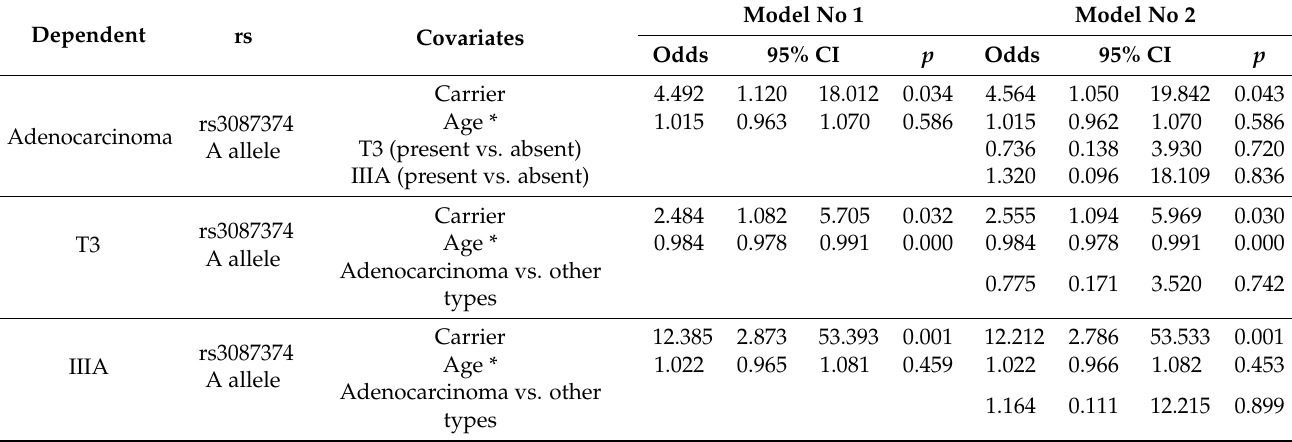
* Age at the time of diagnosis. T3, size of primary tumor according to TNM classification. IIIA, stage IIIA of cervical cancer. Model No. 1, the logistic regression analysis adjusted for age at diagnosis. Model No. 2, the logistic regression analysis adjusted for age at diagnosis and selected parameters. CI, confidence